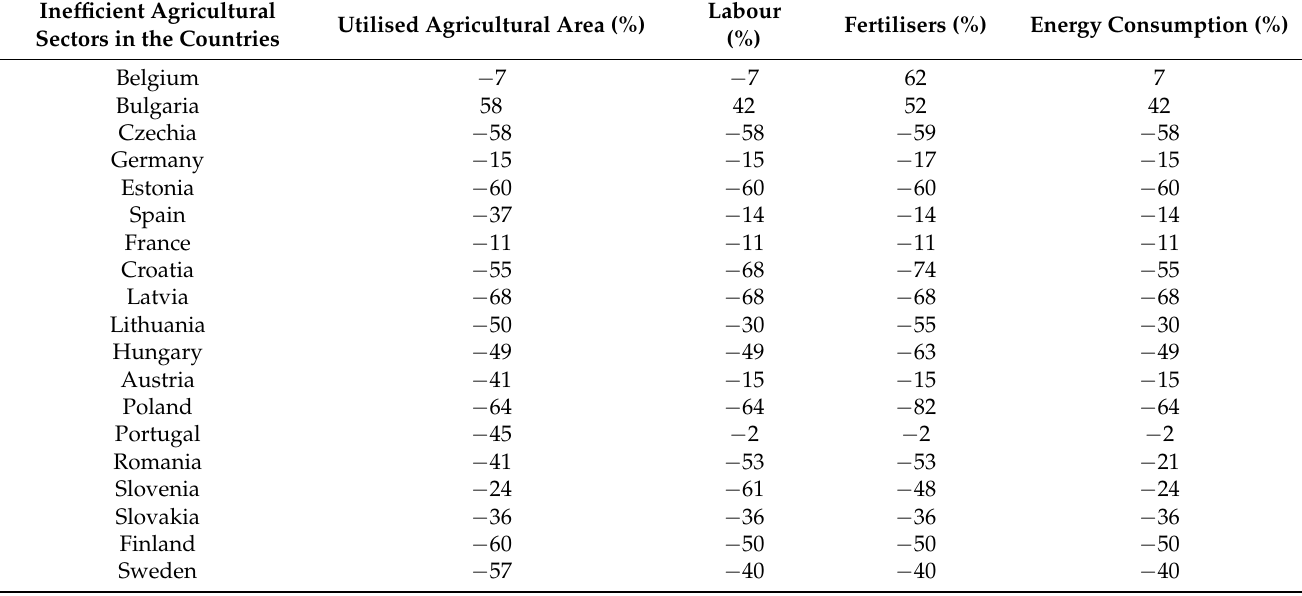
Table 5. Recommendations regarding reduction of agricultural input in particular countries in order to achieve efficiency. Inefficient